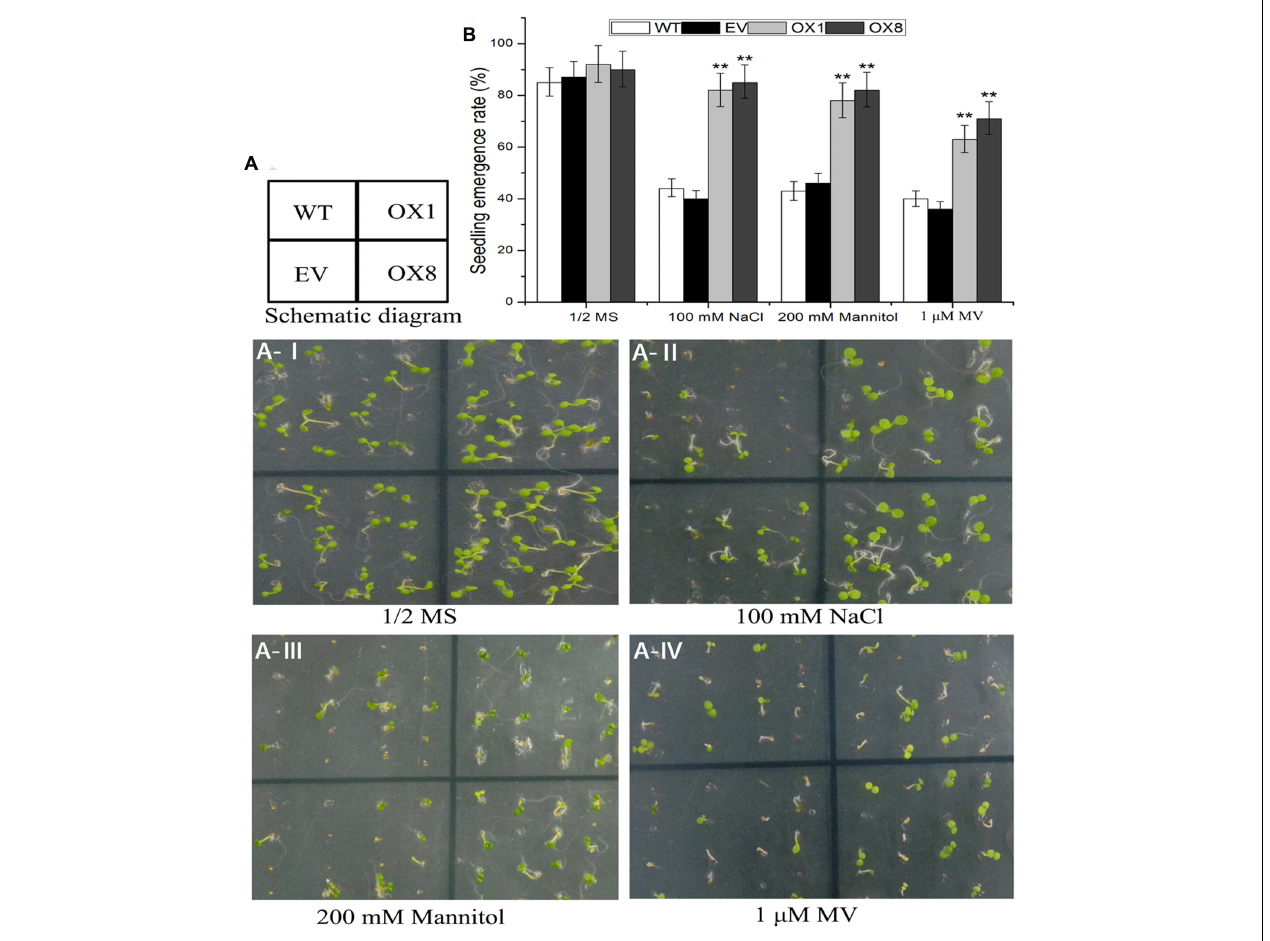
FIGURE 6 | Seedling emergence assays of WT, EV and TaNAC2D -OX plants. (A) Seedling emergence performance of WT, EV, and OXs grown for 8 days on 1/2 MS medium (control) or 1/2 MS medium containing 100 mM NaCl, 200 mM Mannitol, and 1 µ M MV. (B) Seedlings emergence rate of WT, EV, and OXs. Data are means ± SE of three biological replicates ( n = 40 to 50 seeds per genotype per experiment). Asterisks indicate significant differences from WT ( ∗∗ P <